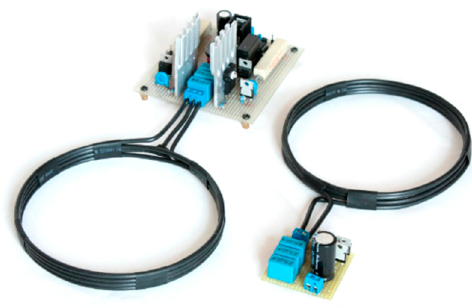
Figure 4. Inductive WPT charging system.